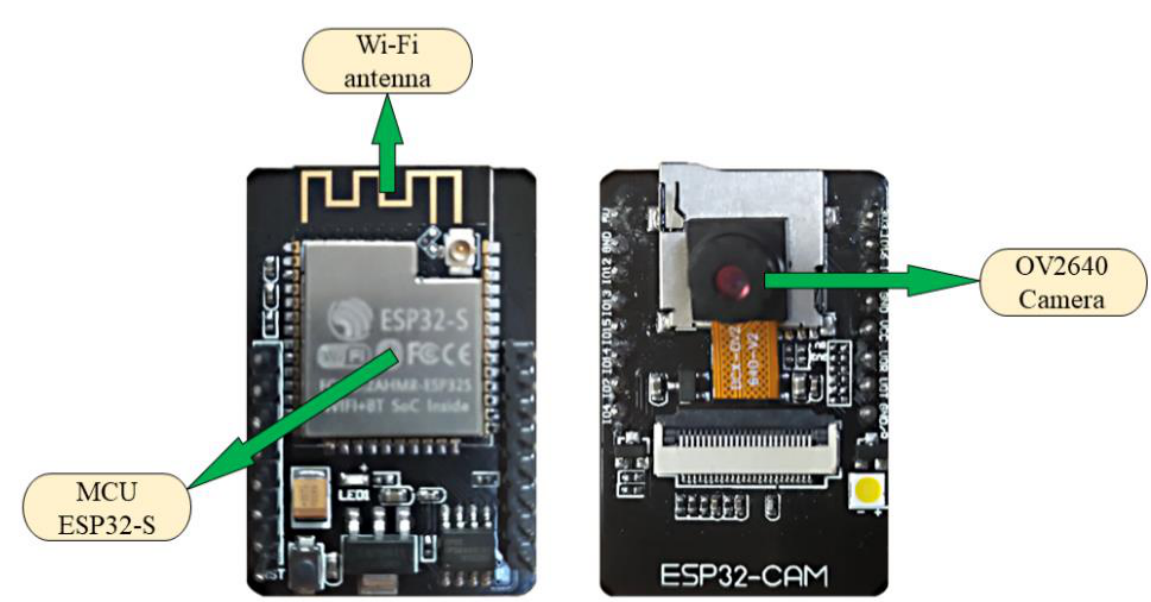
Figure 2. Block diagram of deep-learning-based wireless visual sensor system.